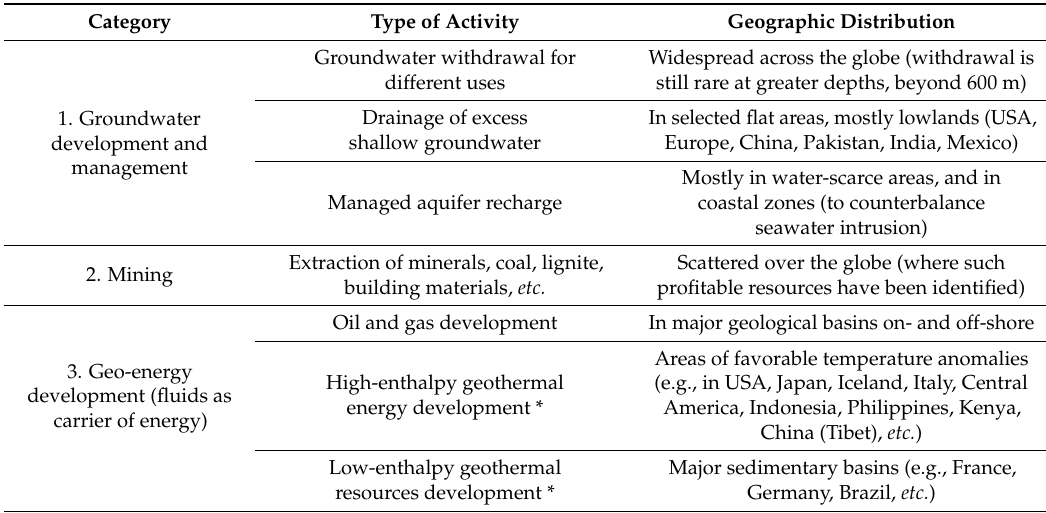
Table 1. Main subsurface human